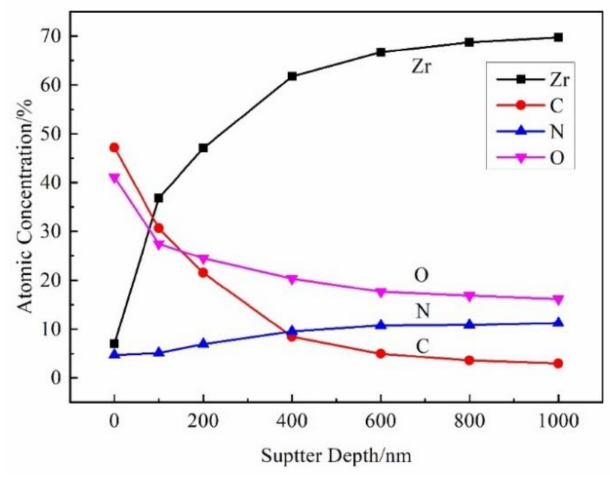
Figure 7. The element distribution of nitride film with different sputtering depths.